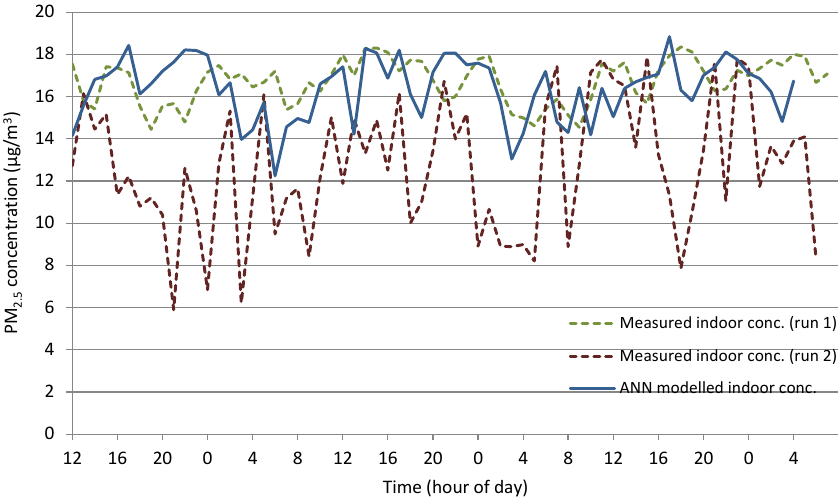
Figure 11. Measured PM 2.5 concentrations versus modelled concentrations at N t 2.